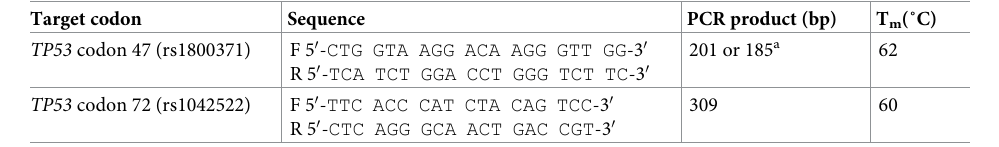
Table 1. Primers for TP53 codon 47 and codon